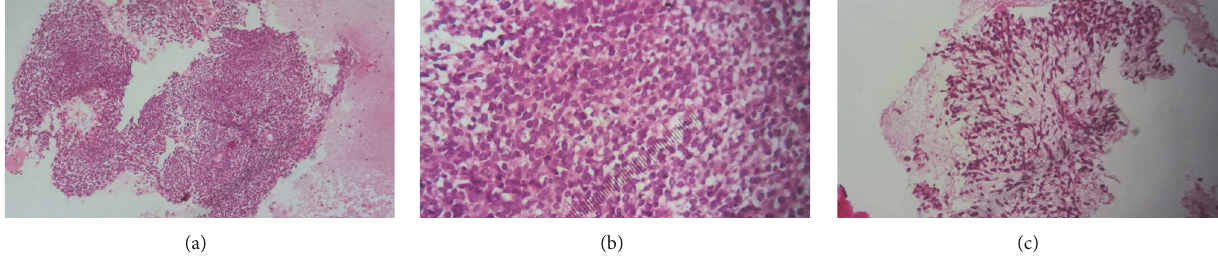
Figure 3: Histologically, (a) the tumor showed spindle-shaped cells forming sheets (Hematoxylin Eosin GX10), (b) the spindle cells are of uniform appearance with oval, dark-staining nuclei and scanty amount of indistinct cytoplasm (Hematoxylin Eosin GX20), and (c) we noted a myxoid pattern (Hematoxylin Eosin GX10).